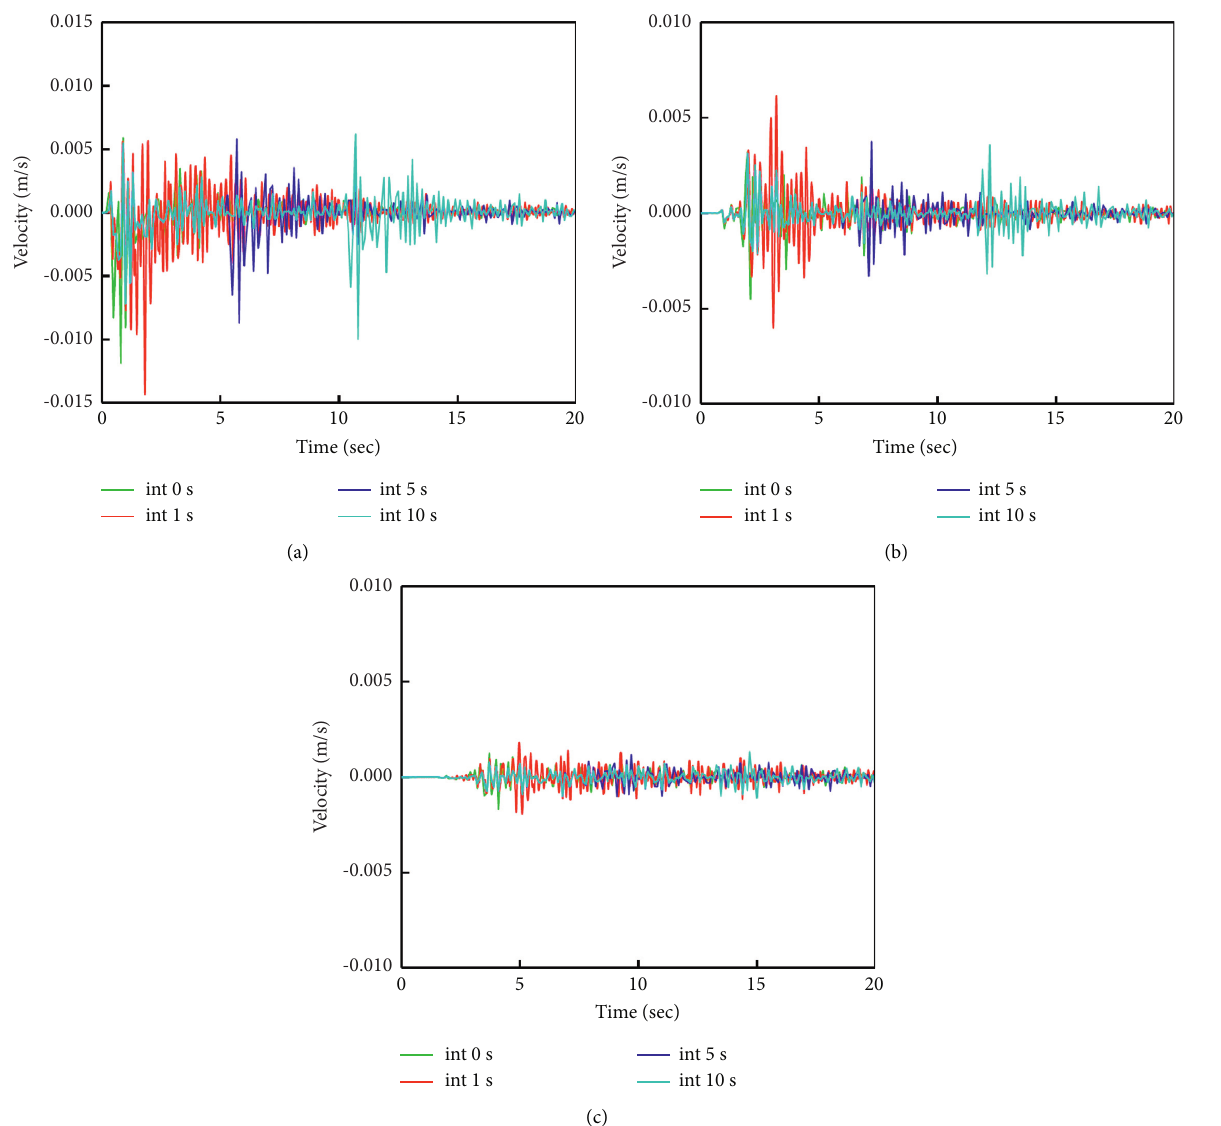
Figure 13: Time-history curves of the peak vertical peak vibration velocities at different measuring points with different time intervals (for the horizontal arrangement): (a) 50m measuring point, (b) 100m measuring point, and (c) 200 m measuring point. V, V3 +5.4e-01